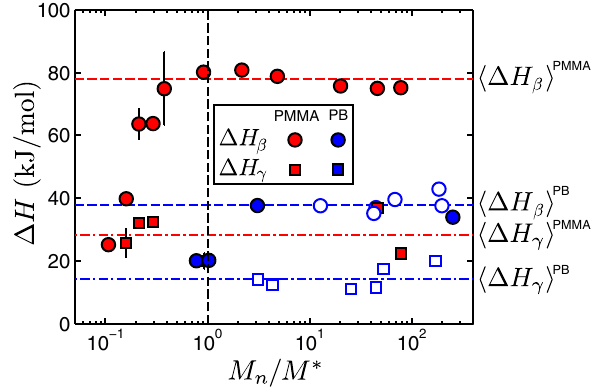
M Þ for PMMA and PB. ; γ ð